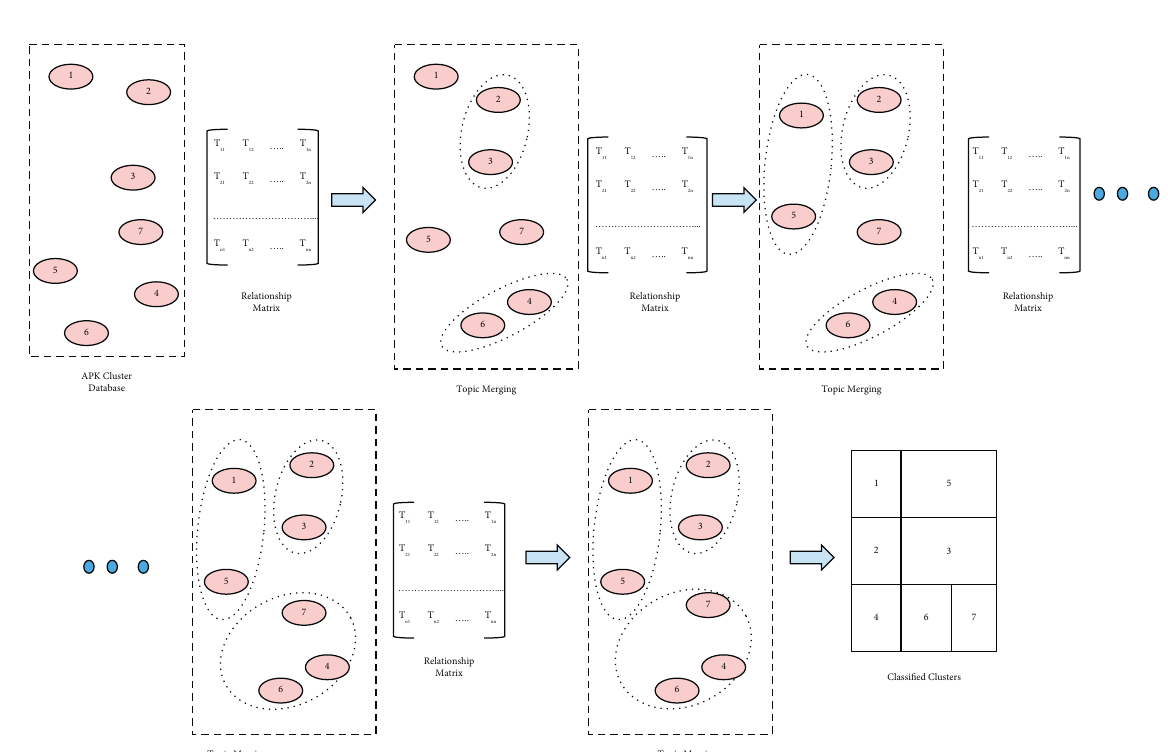
Figure 17: Hierarchical clustering